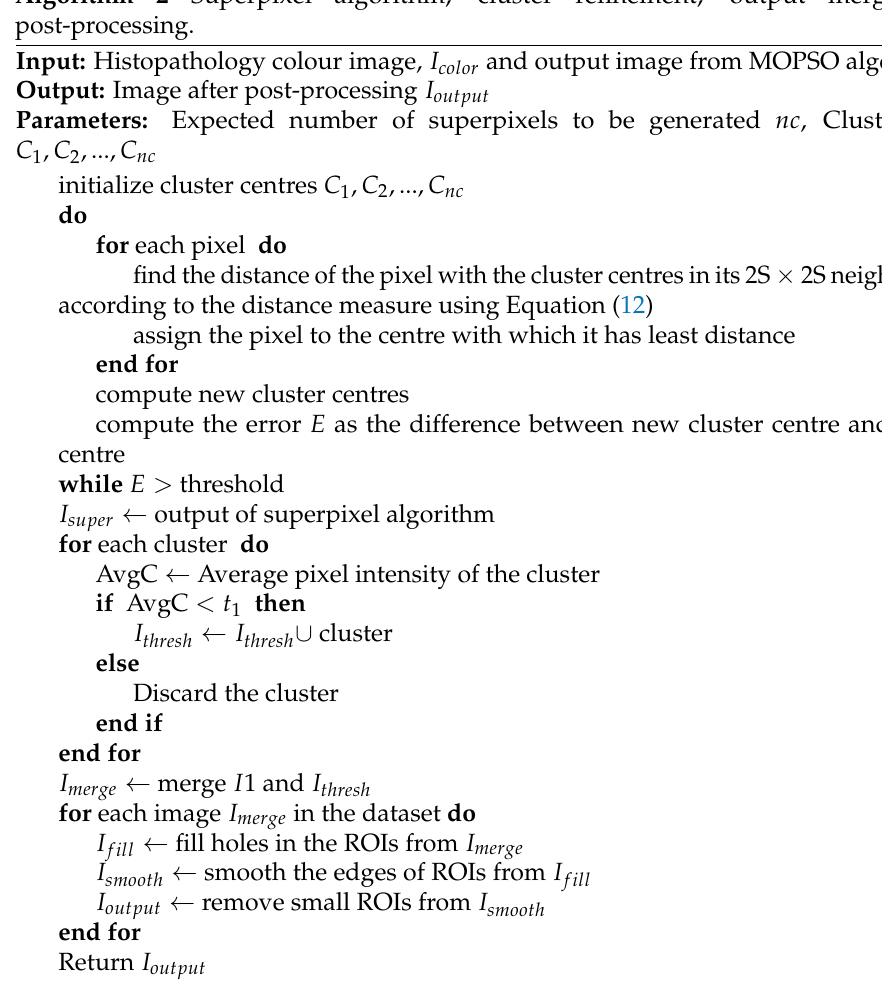
Algorithm 2 Superpixel